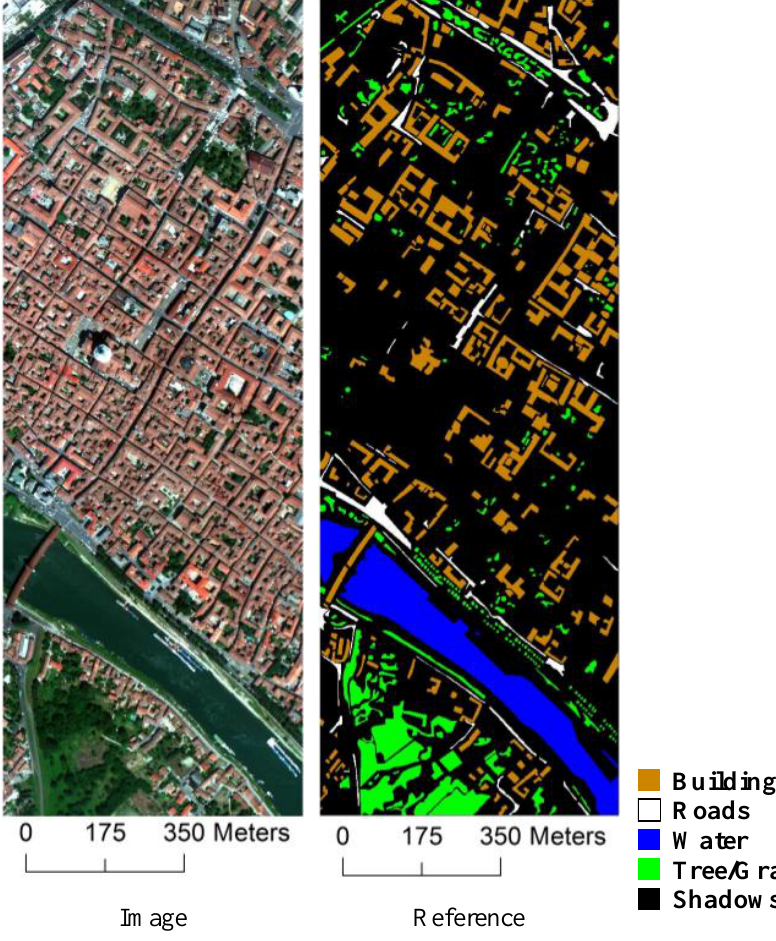
Figure 6. The Pavia City image and its reference